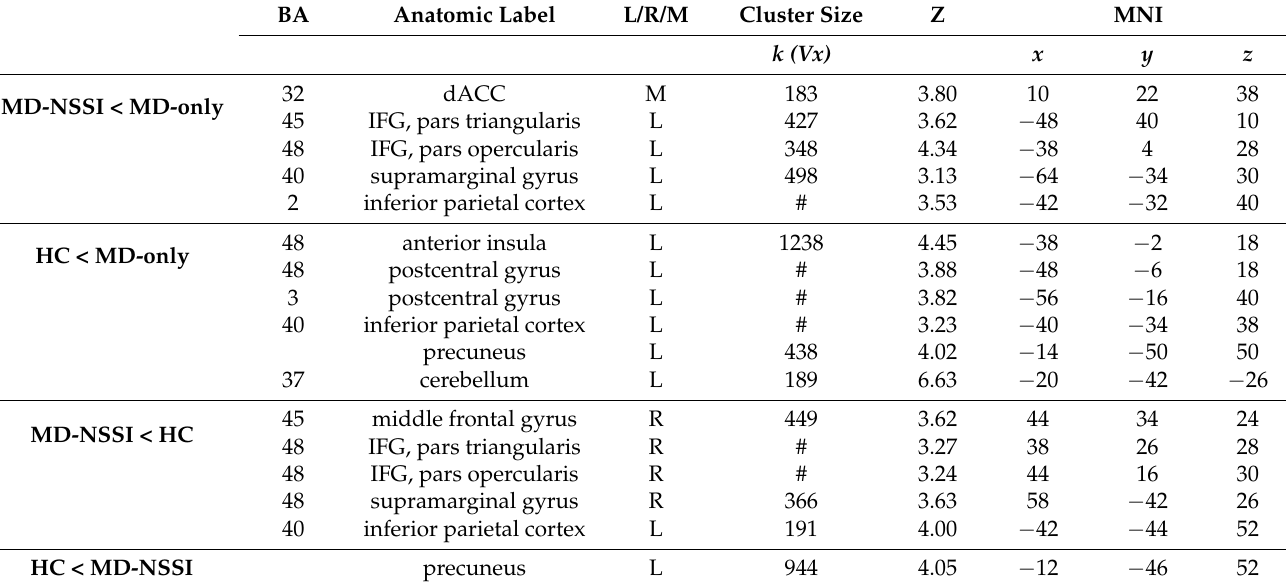
Table 3. Significant ( p ≤ 0.05; minimum cluster size of 183 contiguously significant voxels at p < 0.005, uncorrected) between-group differences in differential neural activations from the contrast ‘incorrect minus correct incongruent No Go trials’ corresponding to neural error signaling. Depressed adoles- cents with comorbid non-suicidal self-injury: MD-NSSI (n = 14); adolescents with major depression: MD-only (n = 12; no first-level contrast in 1 patient with zero No Go errors); healthy controls: HC (n = 14).